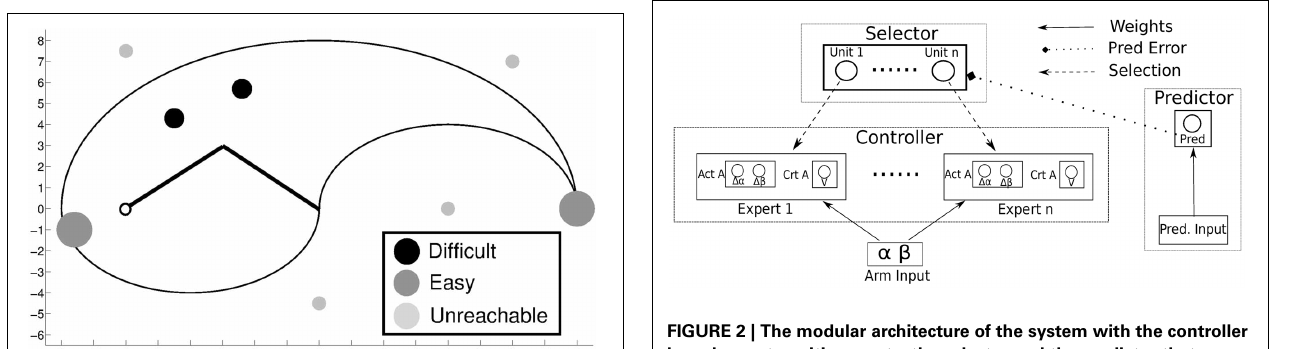
FIGURE 2 | The modular architecture of the system with the controller based on actor-critic experts, the selector and the predictor that generates the IM reinforcement signal driving the selector. n is the number of the tasks; Act A is the output of the actor of the expert, controlling the displacement of the joints of the arm in the next step; Crt A is the evaluation made by the critic of the